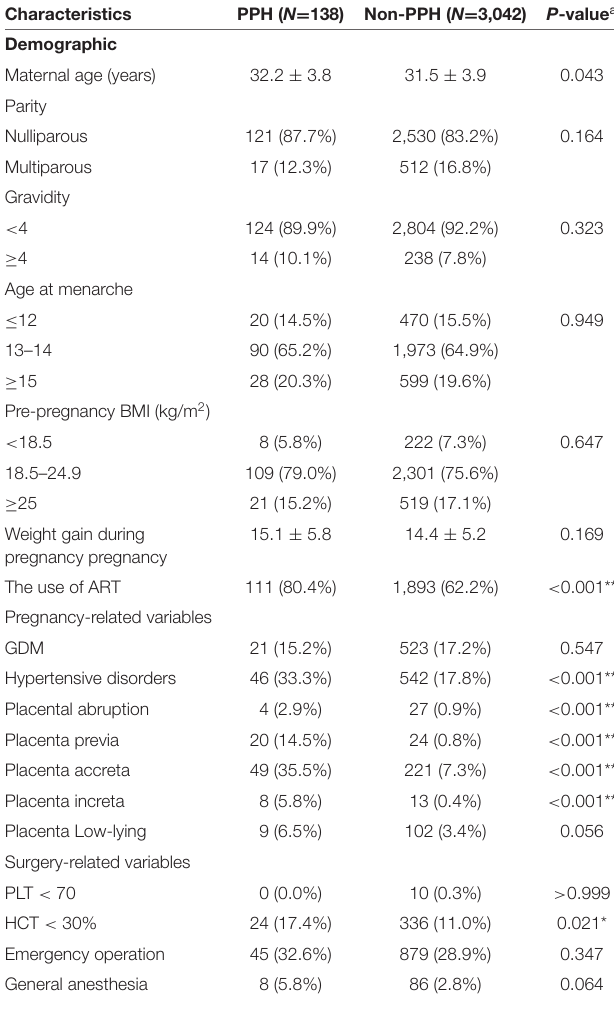
TABLE 1 | Baseline characteristics of twin pregnancies complicated by PPH compared to non-PPH twin pregnancies.